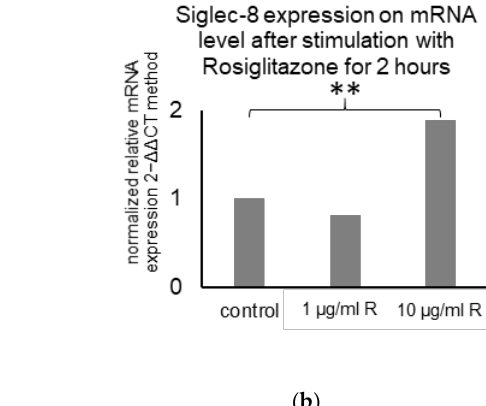
Figure 7. Mean relative Gal-7 expression on mRNA level (calculated with the 2 −ΔΔCT method) in MCF7 cells dependent on Siglec-8 silencing. Expression in control cells is displayed and expression in cells, where Siglec-8 was silenced with 5 nM siRNA A, B and C for 48 h, is normalized on the expression in control cells. GAPDH was used as endogenous control for ΔCT-values and the results are means of triplicates. siRNA A and siRNA B led to significantly reduced Gal-7 expression.